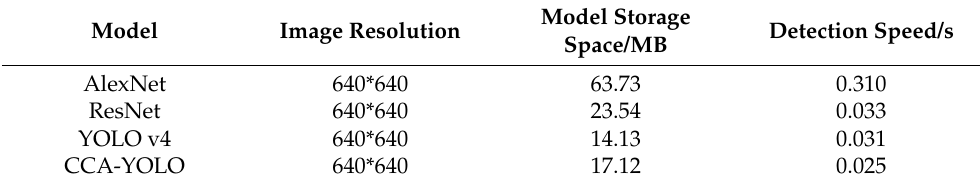
Table 6. Performances of different